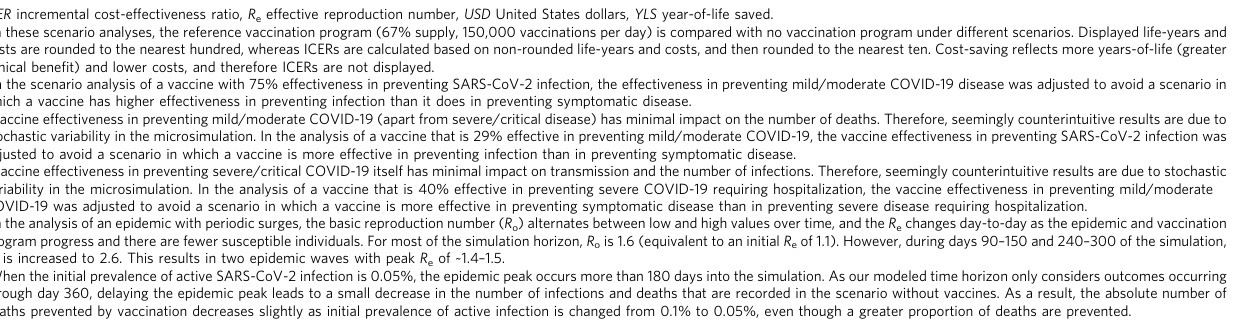
Table 2 One-way sensitivity analyses of different COVID-19 vaccine characteristic and epidemic growth scenarios in South Africa. SARS-CoV-2 infections averted, compared with no vaccination Vaccine effectiveness in preventing SARS-CoV-2 infection, %